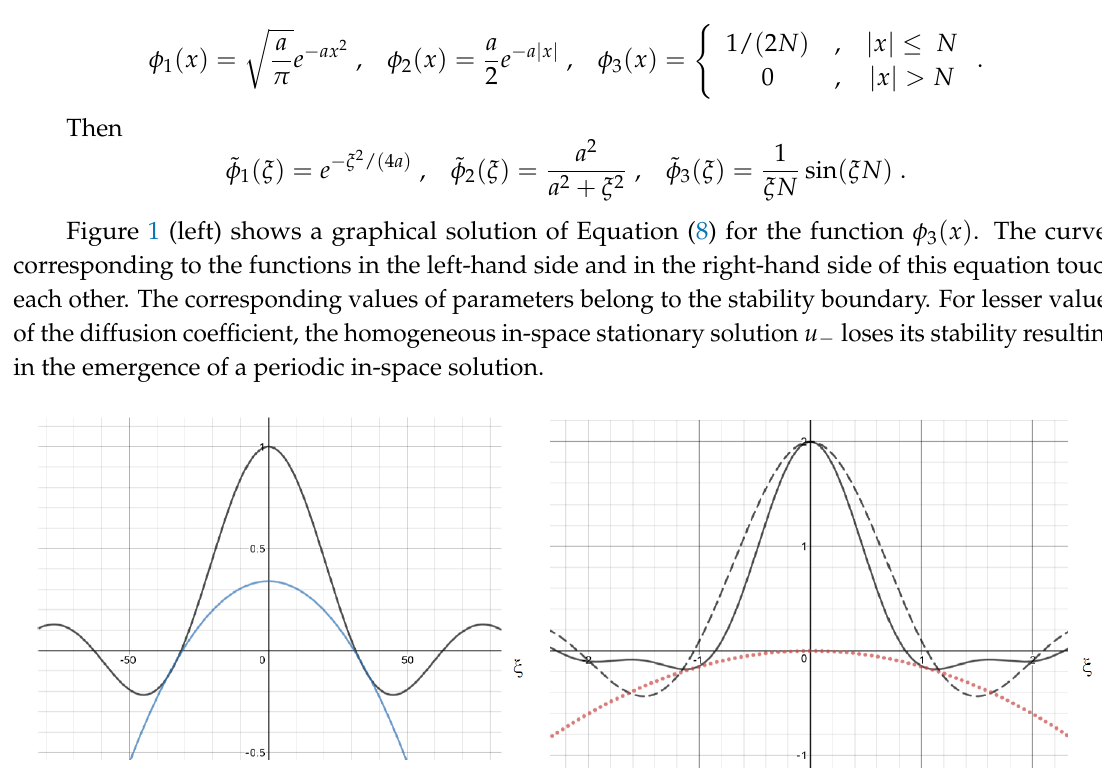
Figure 1. ( Left ) Graphical solution of Equation (8): functions ( sin ( ξ N )) / ( ξ N ) and − f (cid:48) ( u 0 ) − D ξ 2 / u 0 , where N = 0.1, f (cid:48) ( u 0 ) = − 0.34, D = 0.00033, u 0 = 0.93. ( Right ) Graphical solution of Equation (11): the function φ ( ξ ) + b ˜ ψ ( ξ ) for the values of parameters b = 1, N 1 = 3, N 2 = 5 (solid line), N 1 = 3, N 2 = 3 (dashed line), and the function − D / u − ξ 2 with D / u − = 0.1508 (point